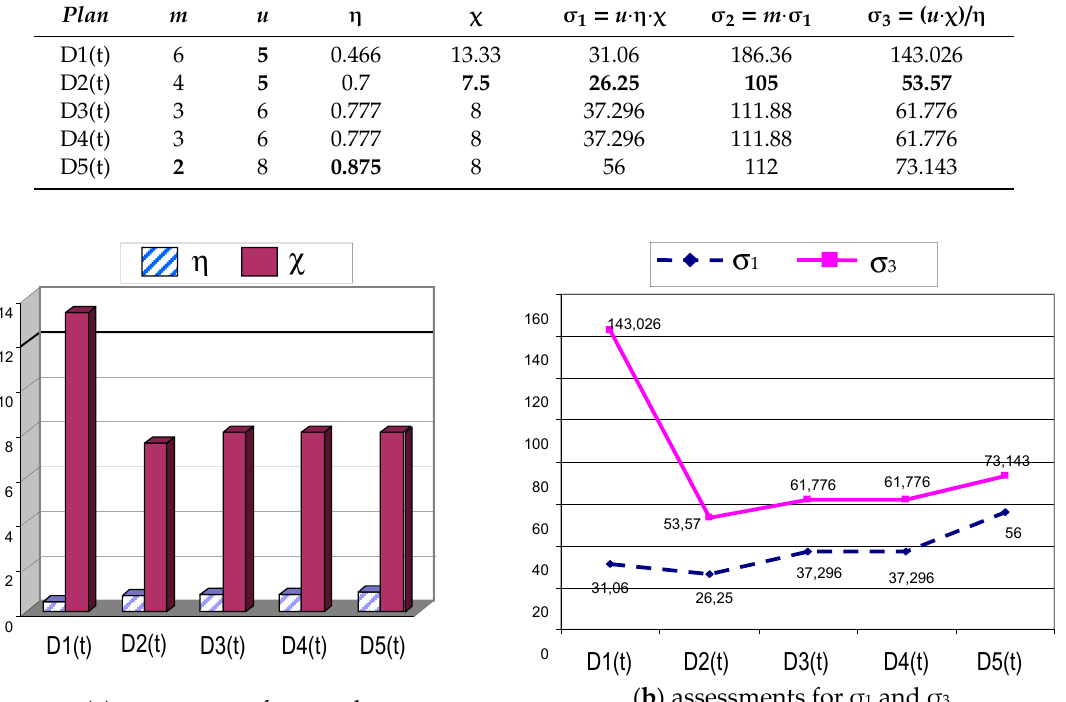
Figure 9. Graphical interpretation of assessments.